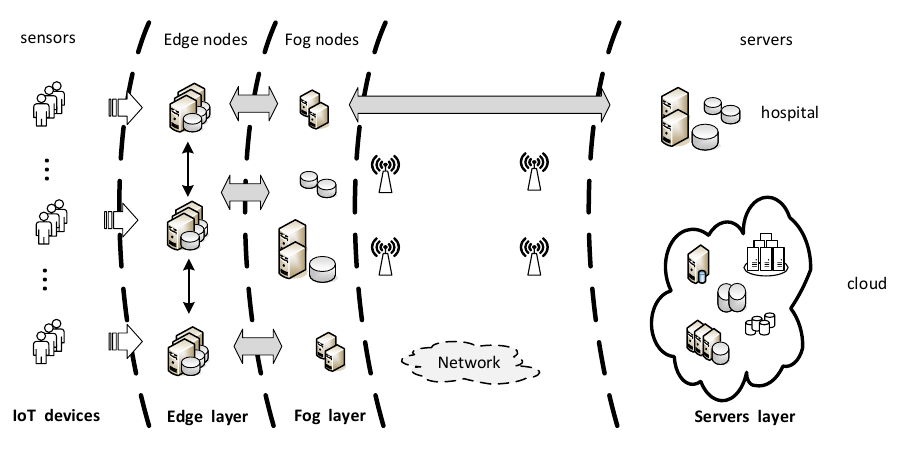
Figure 19. The considered e-Health